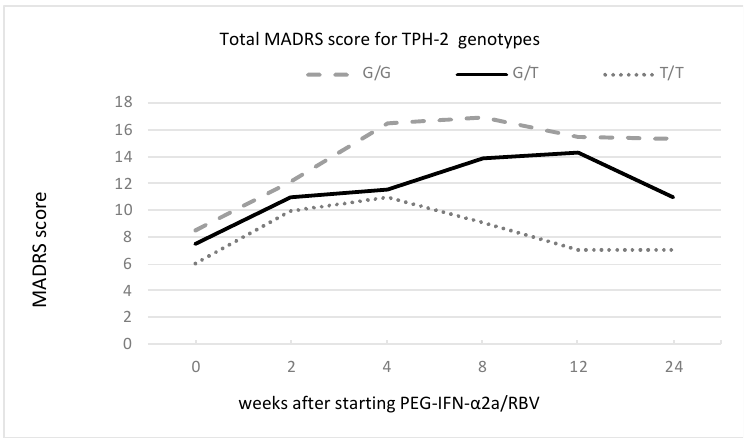
Figure 3. Changes in MADRS score for TPH-2 genotypes of G/G, G/T, and T/T during PEG-IFN- α 2a/RBV treatment. Table 4. Multilevel regression analyses indicating di ff erences in MADRS score for each time point compared to baseline, with β indicating regression coe ffi cient and p the level of signi fi cance for patients with genotypes of 5-HT1A, TPH-2, and functional 5-HTTPLR.